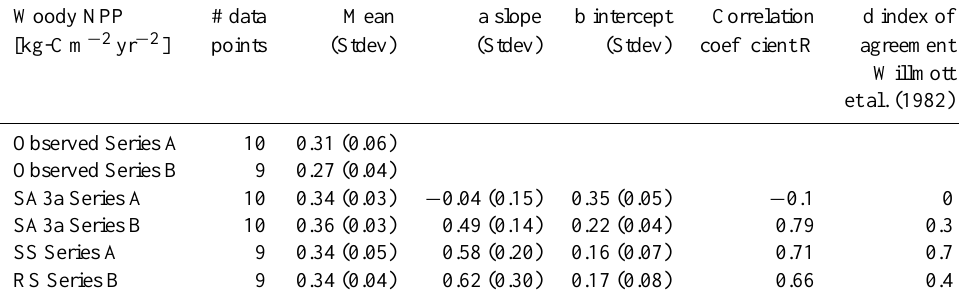
Table 3. Statistical summary of the comparison of woody net primary productivity between IBIS-simulated results and field estimates. The table presents the number of data points within the studied area, mean and standard deviation, regression slope, intercept and correlation coefficient, and index of agreement (d). The statistical analyses were made for all sites excluding four outliers (JEN, CAQ, SCR, CUZ, discussed in Supplement D). The statistical analyses were divided in groups of data point as follows: Series A and B represent the series of all data points that have available NPP w field information; Series A represents the series of data where the V cmax was estimated based on field information; and Series B represents all other data points where NPP w field was known and V cmax was extrapolated based on the methodology described in this work.